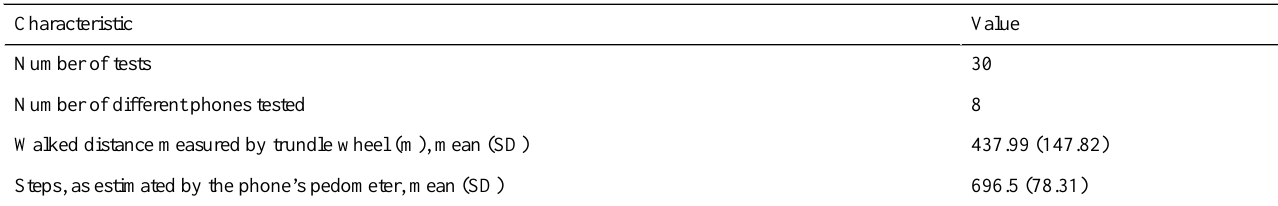
Table 3. Characteristics of the outdoor